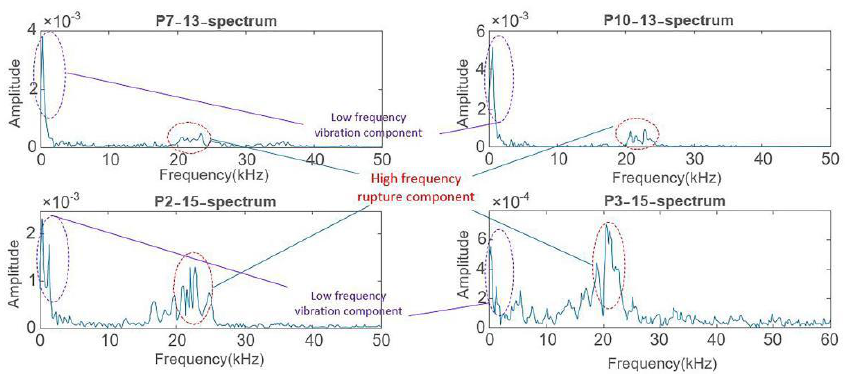
Figure 11. Spectra of the waveforms in subpictures P7 – 13 and P10 – 13 in Figure 6, and those in sub- pictures P2 – 15 and P3 – 15 in Figure 8. There are two peak intervals in each spectrum: the low-fre- quency peak interval is 1~3 kHz, whilst the high-frequency peak interval is 20~30 kHz.